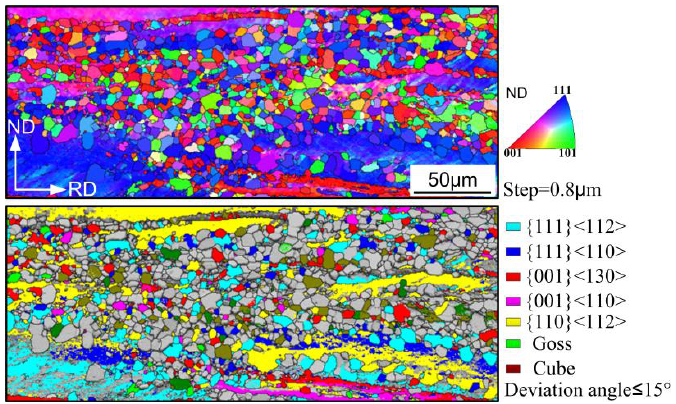
Figure 7. Inverse pole figure map (IPF) and relevant orientation image maps (OIM) of several main components in the partially recrystallized OCR sample.